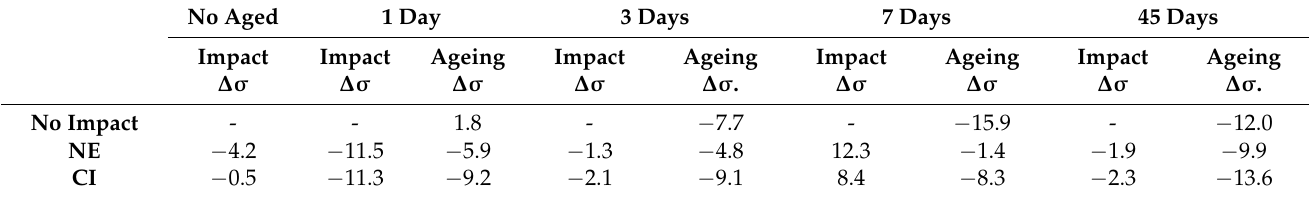
Table 5. Compressive residual strength variations (mean values, reported in